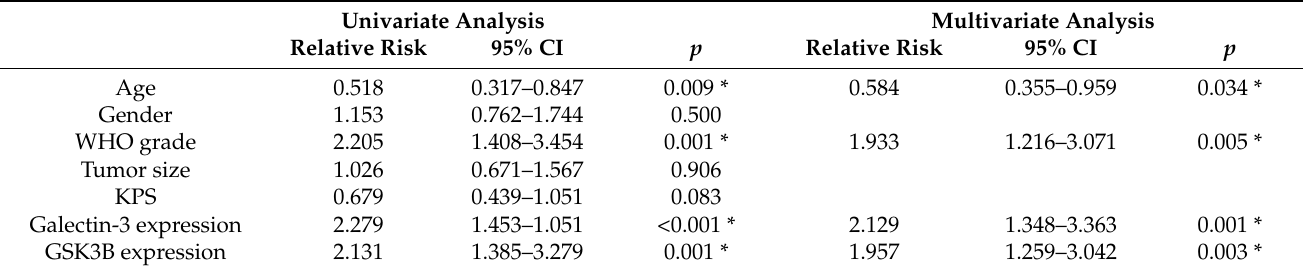
Table 2. Univariate and Multivariate analysis of different prognostic parameters in patients with astrocytoma by Cox-regression analysis.